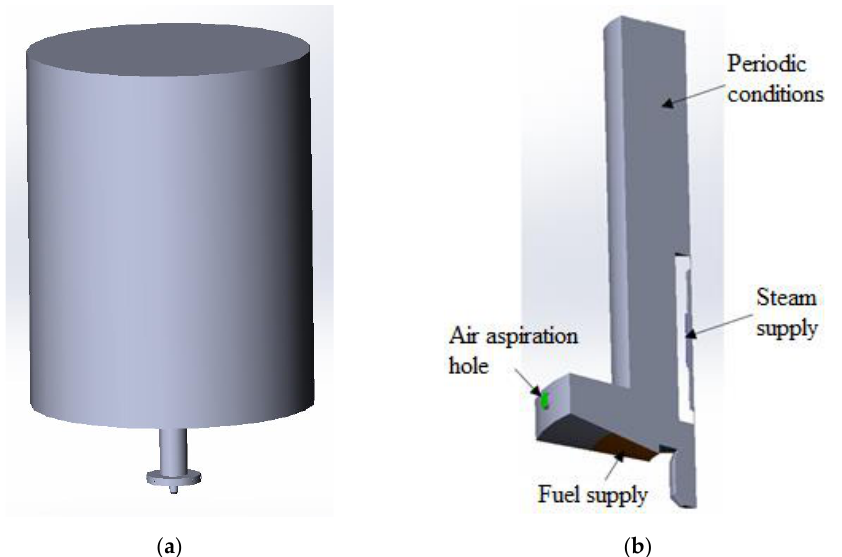
Figure 3. Geometry of computation domain: ( a ) full; ( b ) in the form of a sector.